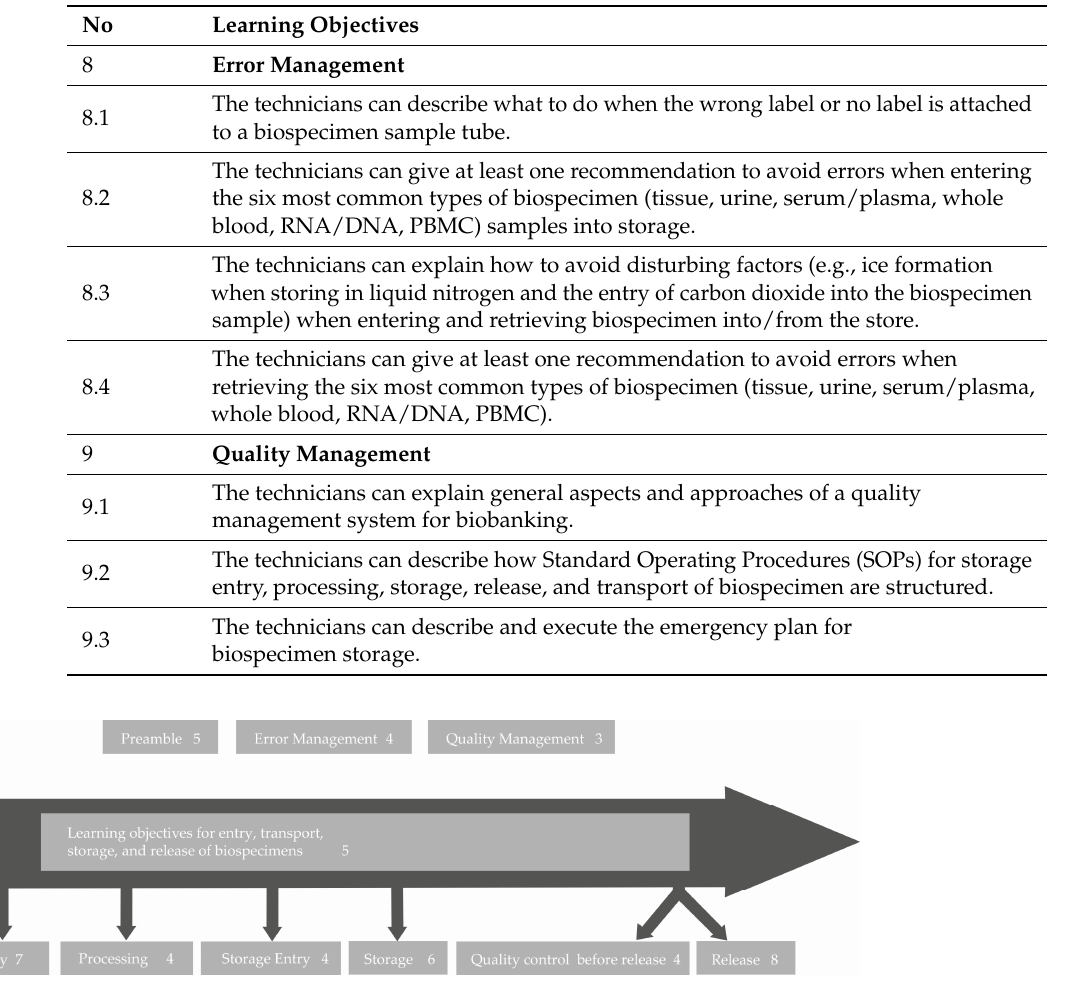
Figure 4. A sorting of the identified learning objectives along the typical biospecimen life cycle within a biobank. The numbers behind the topics are the numbers of learning objectives generated in this area. Table 1. List of the 41 learning objectives, sorted according to nine main biobanking categories.